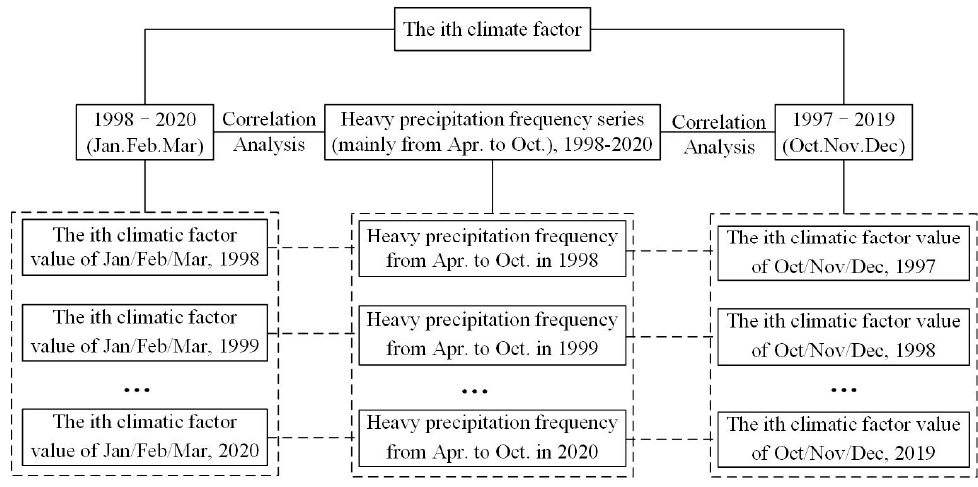
Figure 2. Schematic diagram of extraction method of climate factors.